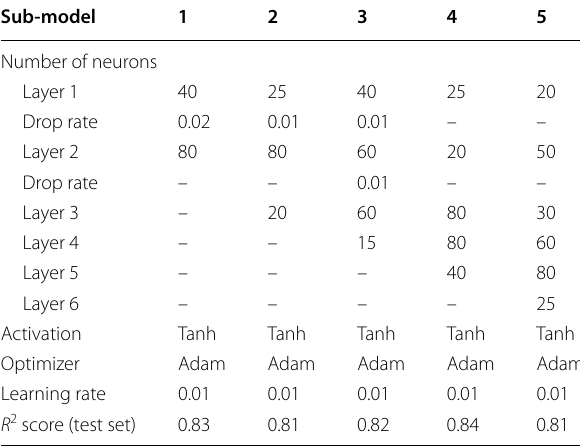
Table 4 Characteristics of the basic models.